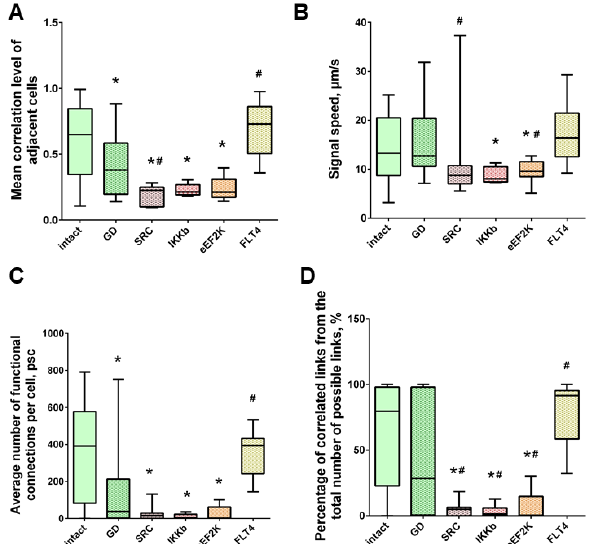
Figure 7. Neuron-glial network activity reorganization in primary hippocampal cultures. ( A ) Mean correlation level of adjacent cells; ( B ) the rate of signal delay between cells; ( C ) average number of functional connections per cell; ( D ) the percentage of correlated connections from the total number of possible connections. * versus “Intact”, # versus “GD”, p < 0.05, the Mann-Whitney test.